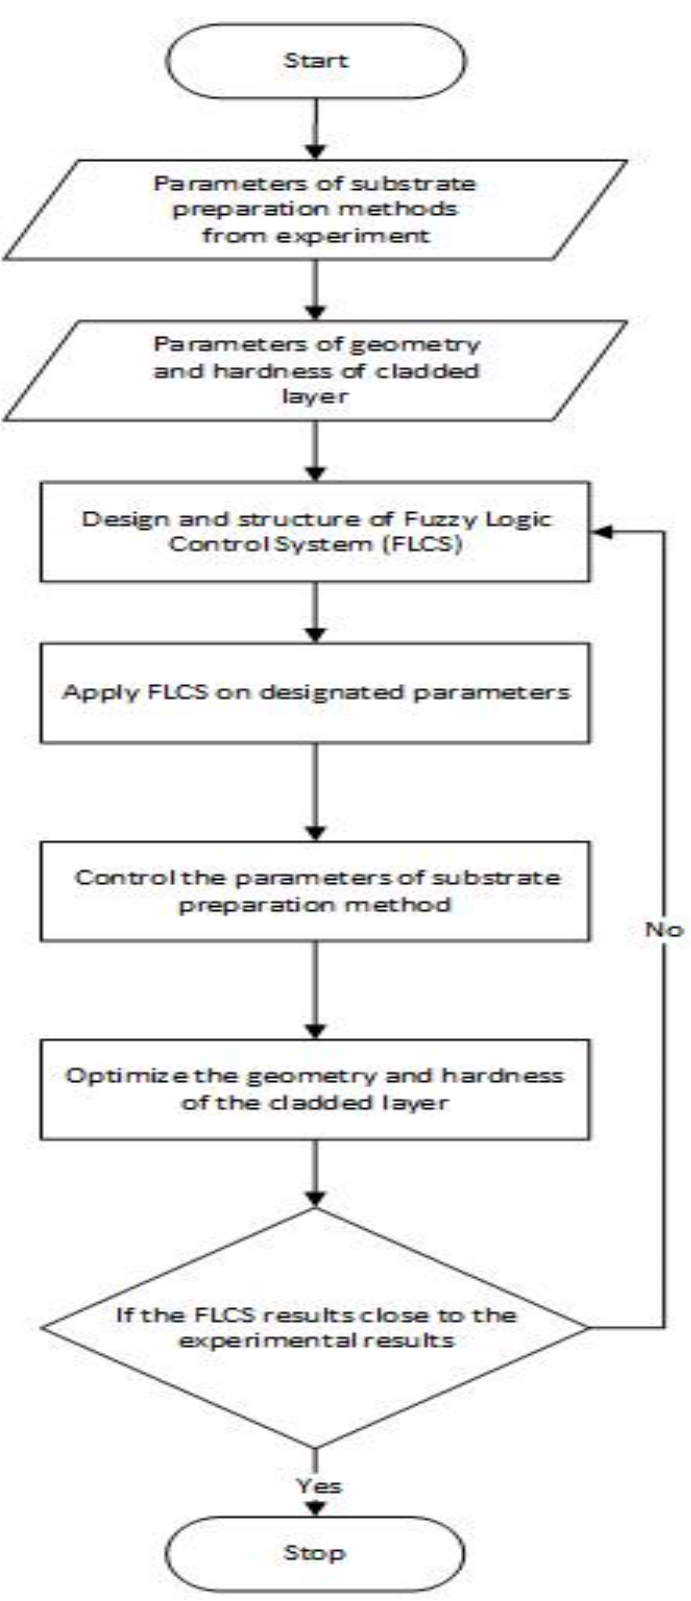
Figure 4. Flow chart of FLCS developed to optimize the geometry and hardness of laser-cladded Fe-based MG.